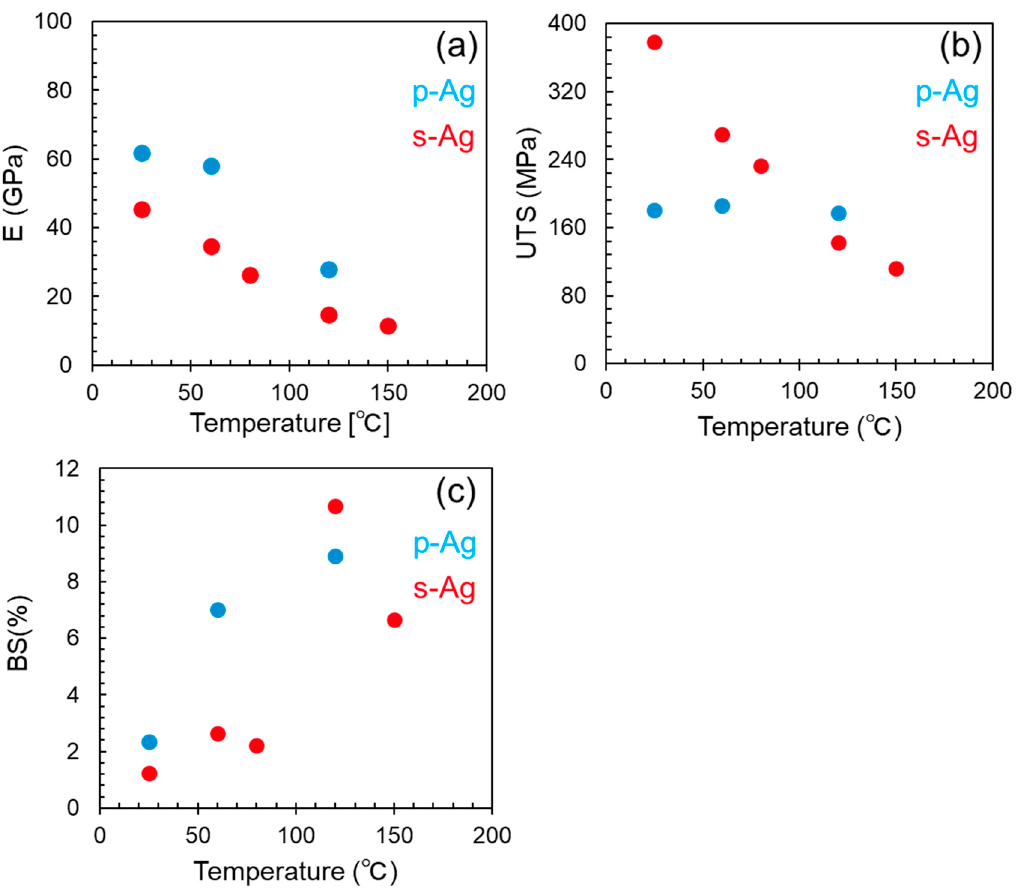
Figure 5. ( a ) Young’s modulus € , ( b ) ultimate tensile strength (UTS), and ( c ) breaking strain (BS) as a function of temperature. The red and blue-colored points denote the data of s-Ag and p-Ag, respectively.